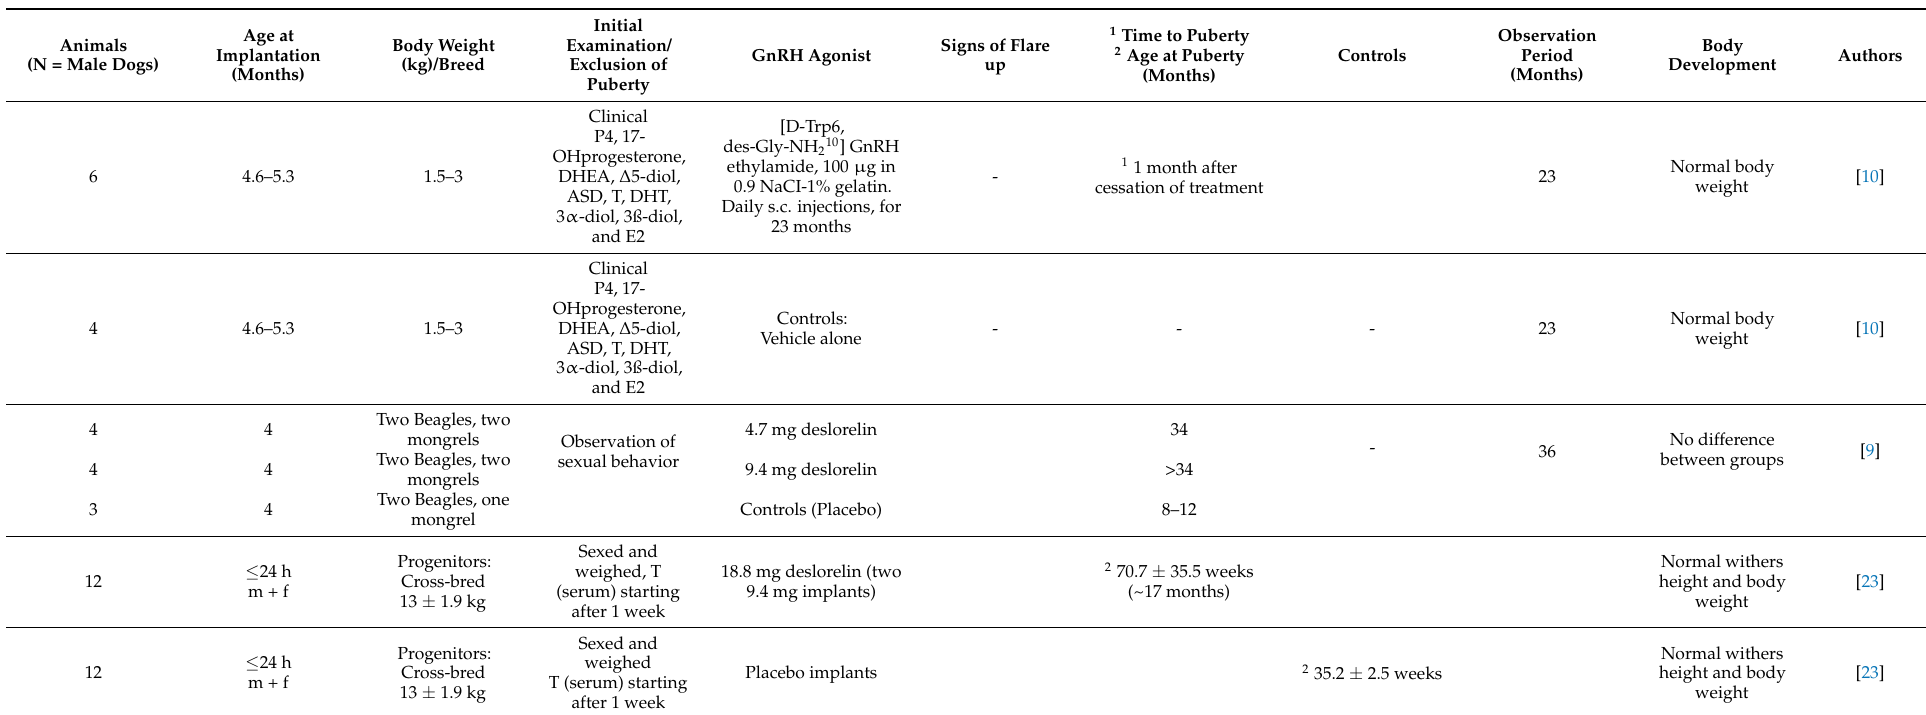
Table 2. Experiments using GnRH agonists for postponement of puberty in male